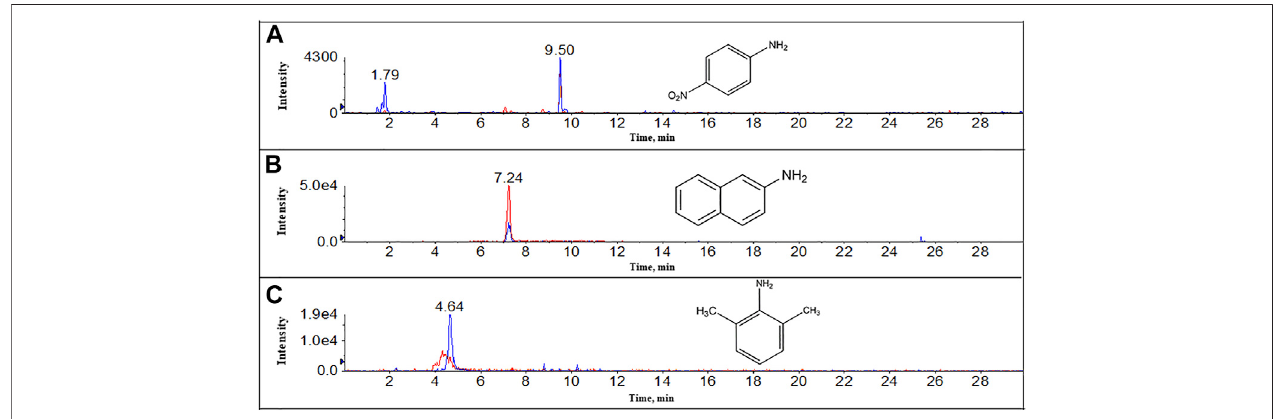
FIGURE6| Extractedionchromatogram(XIC)ofthetwotransitions to (A) 4-nitroaniline (B) 2-naphthylamine,and (C) 2,6-dimethylaniline inthecollected sample2 (treated ef fl uent) by LC-MS/MS-SRM.